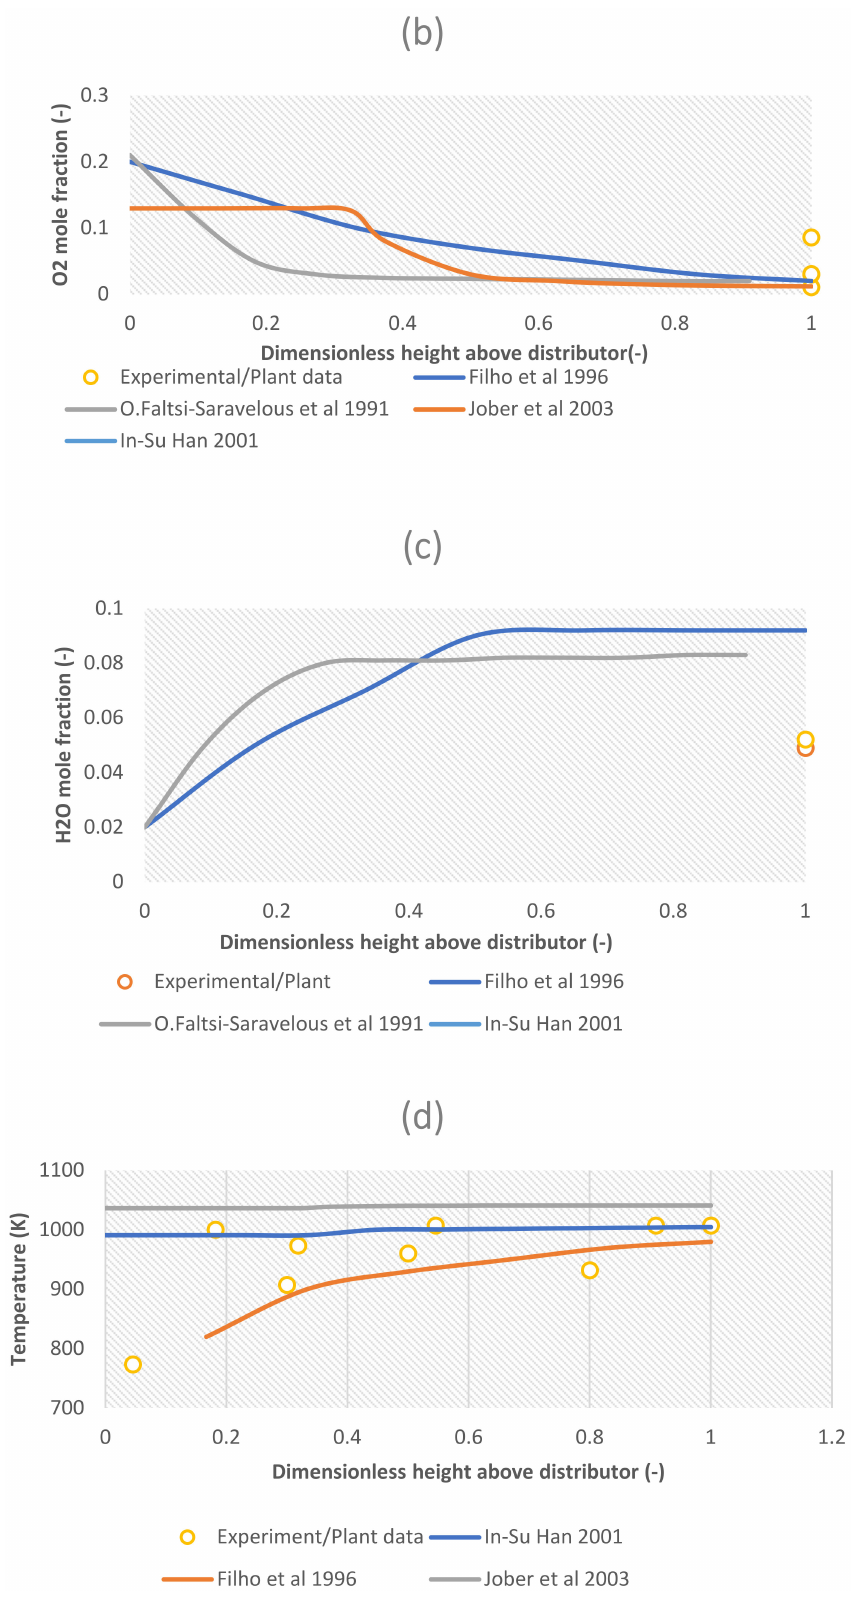
Figure 4. Comparison of predictions from FCC regenerator models in the literature against plant/experimental data for ( a ) axial profiles of carbon dioxide, ( b ) axial profiles of oxygen, ( c ) axial profiles of water vapor and ( d ) axial profiles of temperature, along the regenerator. Predictions from [18,131,132,134], and plant/experimental data from